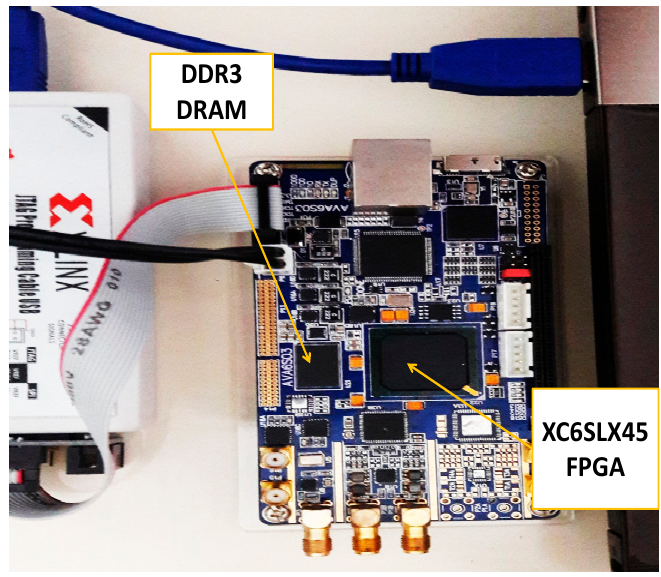
Figure 5. Experimental setup.